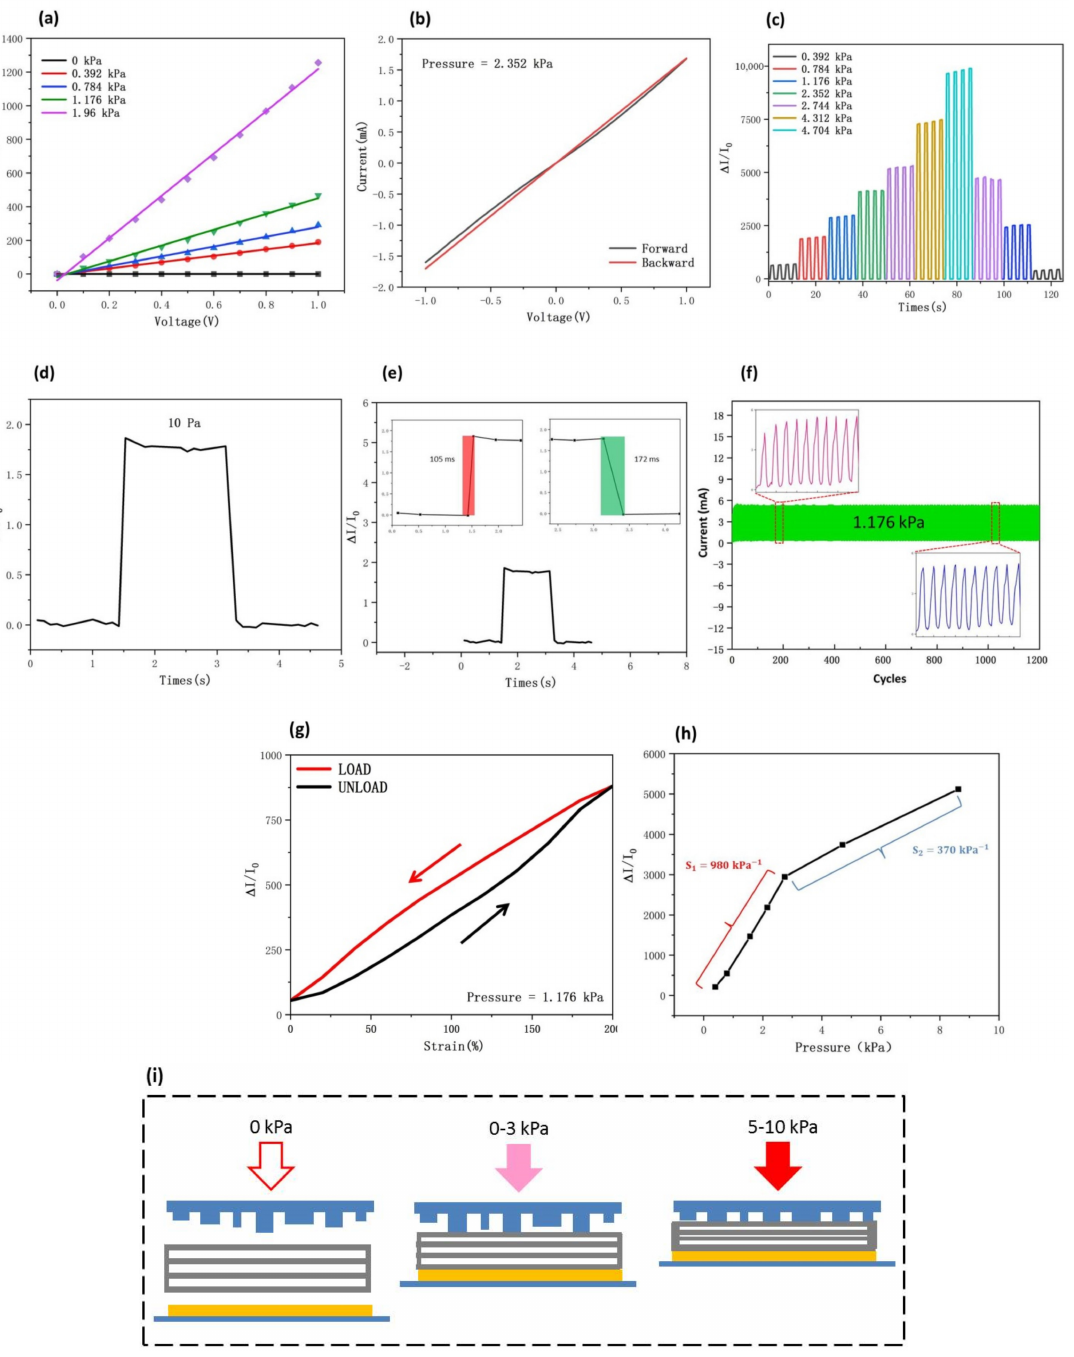
Figure 4. Electromechanical properties of the sensor with 5%MWCNTs@5%Gp conductive film. ( a ) Fitting curves of I-V for different pressures. ( b ) The I-V curves of forward and backward sweeping at a voltage range from − 1 to 1 V under a pressure of 2.352 kPa. ( c ) The I-V curves under different pressures. ( d ) The minimum detection of the sensor. ( e ) The rising and releasing time of the sensor. ( f ) Durability of the sensor for 1200 loading/unloading cycles. ( g ) Hysteresis characteristics of the sensor under a pressure of 1.176 kPa. ( h ) Fitting curves of sensitivity for different pressures. ( i ) Schematic diagram of the working principle of the pressure